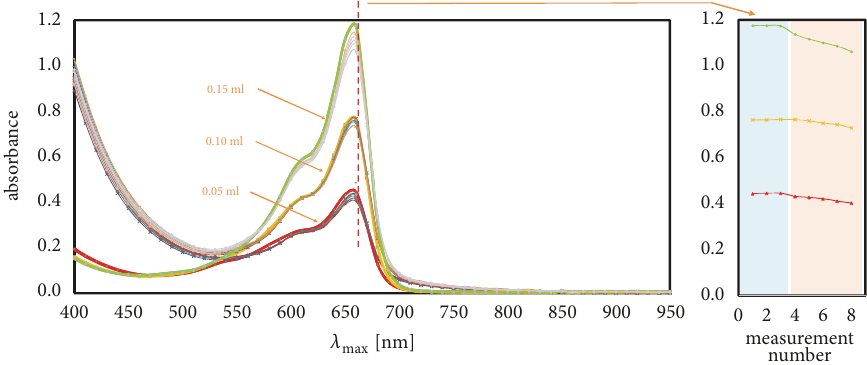
Figure 3: Absorbance curves for selected concentration in function of amount of